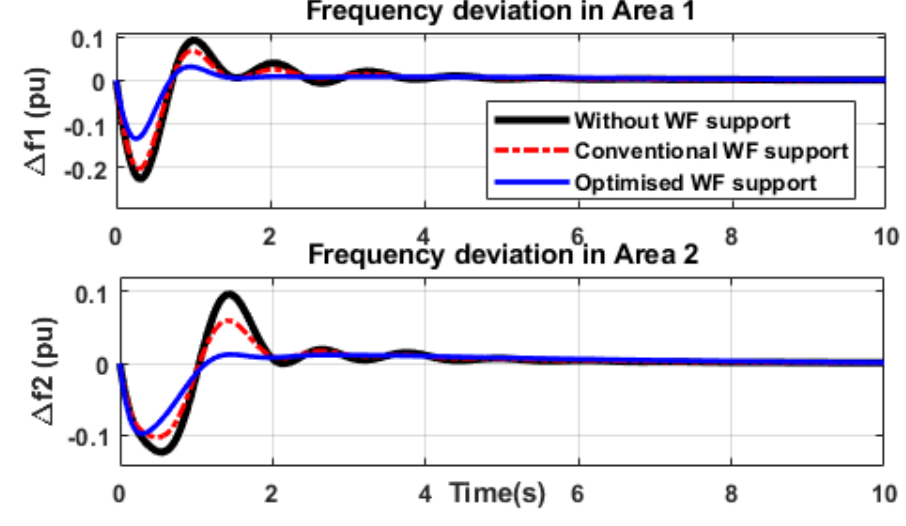
Figure 14. Frequency deviation in bilateral